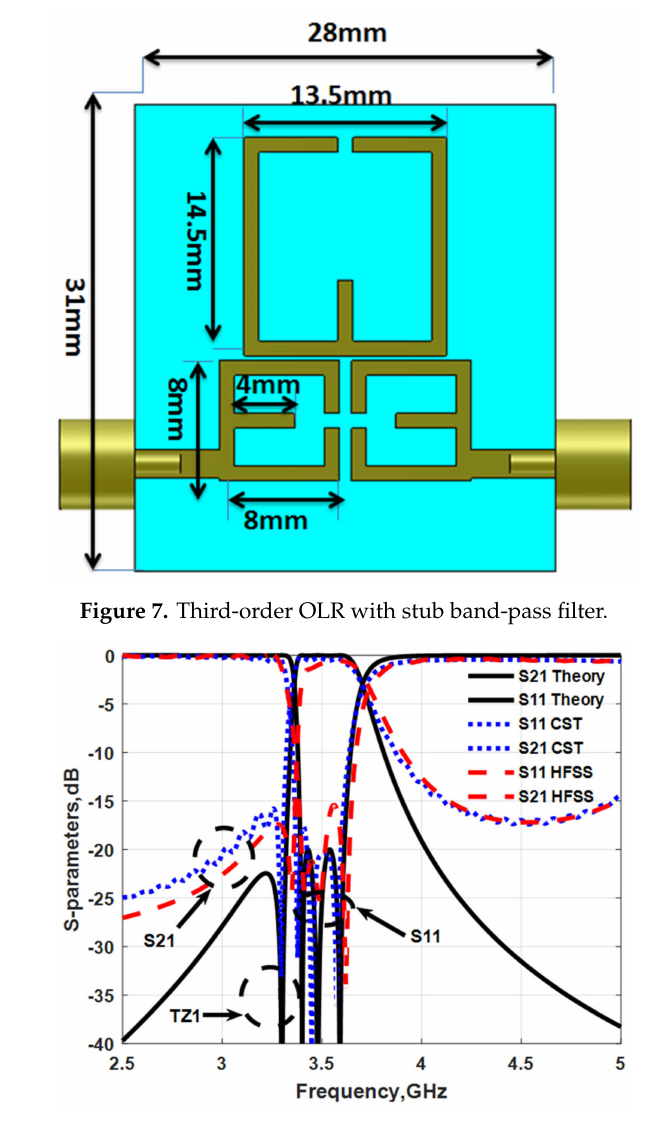
Figure 8. S 11 , S 21 simulated results of the third-order